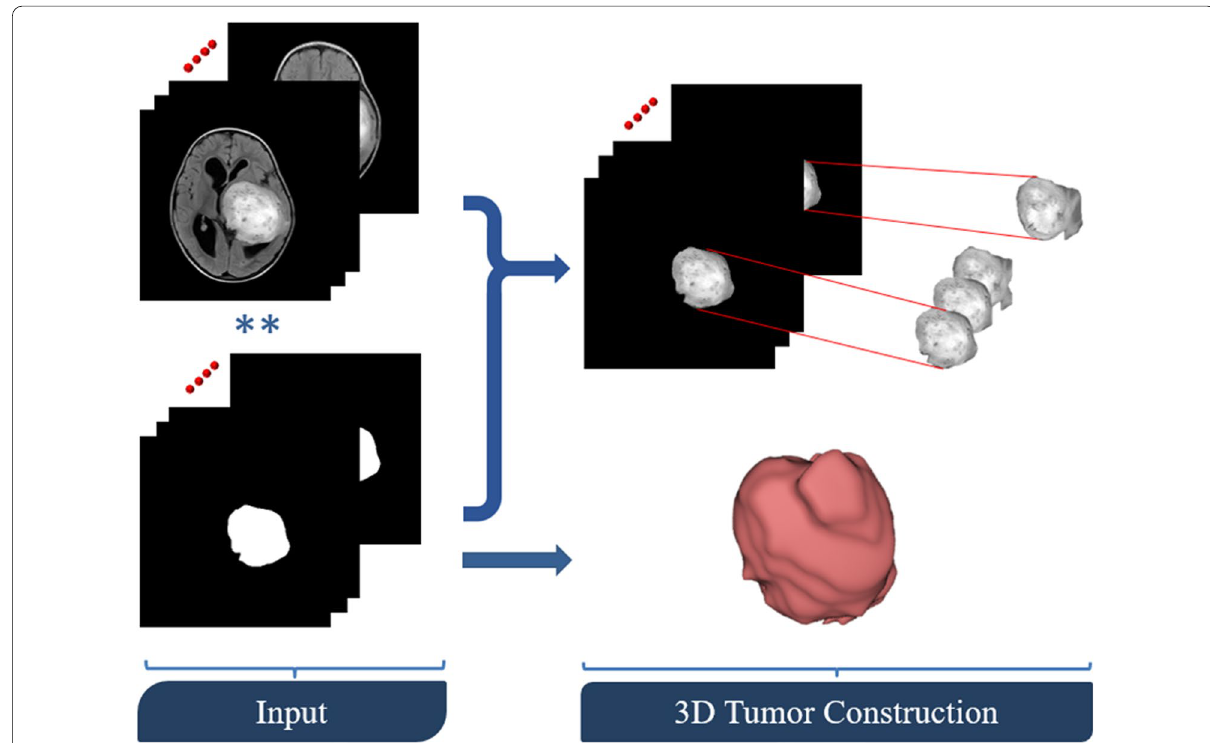
Fig. 2 Pre‑processing step on glioma tumor subject (T2‑FLAIR imaging modality)